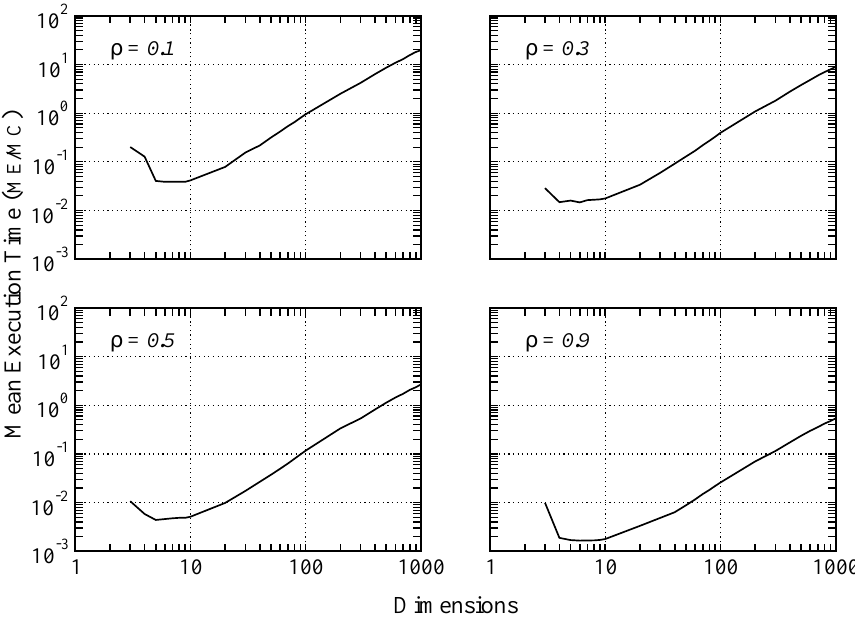
Figure 2. Relative mean execution time ( t ME / t MC ) of Genz Monte Carlo ( MC ) and Mendell-Elston ( ME ) algorithms. ( MC only: mean of 100 replications; requested accuracy (cid:101) =